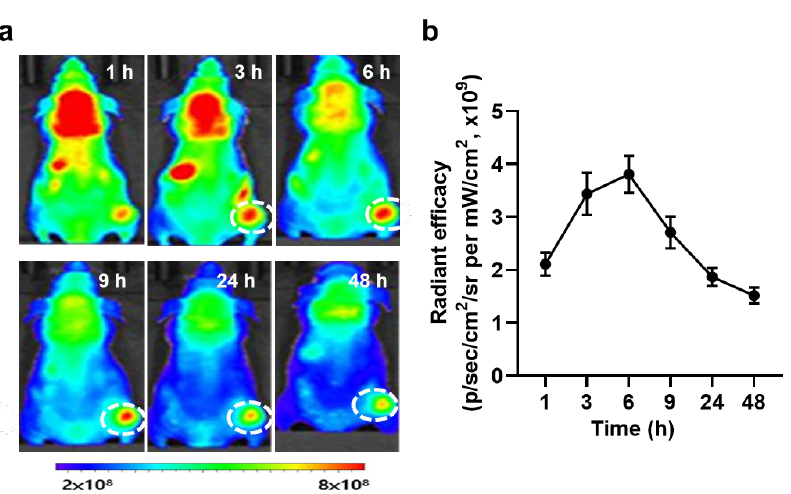
Figure 4. Biodistribution of PS-OT-1 cells. ( a ) In vivo fluorescence images of a tumor treated with PS-OT-1 cells. ( b ) Quantitative analysis of fluorescence intensity in the tumor region.